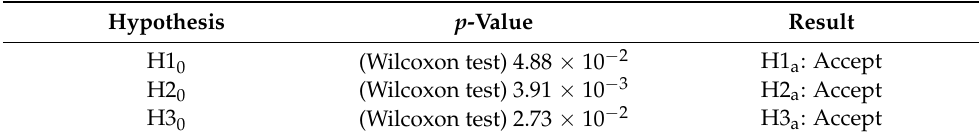
Table 2. Statistical verification